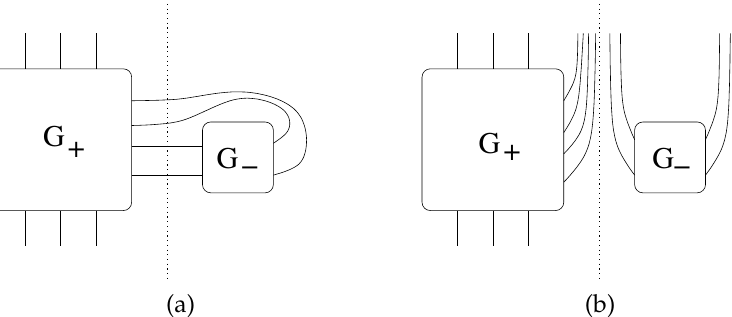
Figure 2. An inhomogeneous Feynman graph contributing to a sixth order Green function of the field φ + . The subgraphs G + and G − belong to ket and bra excitations, respectively. ( a ) The sum of the energies flowing into G − is vanishing hence at least on of the line carries negative energy and the graph is vanishing. ( b ) The alternative representation with the lines indicating the excitations contributing to the trace. This process is suppressed if the energy is vanishing at the initial